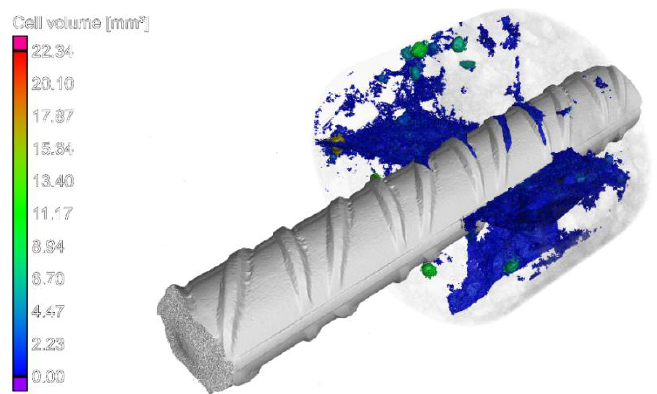
Figure 8. An example of the 3D reconstruction of X-ray CT scan (bottom-up variant of placement. Bottom sample, column 5).